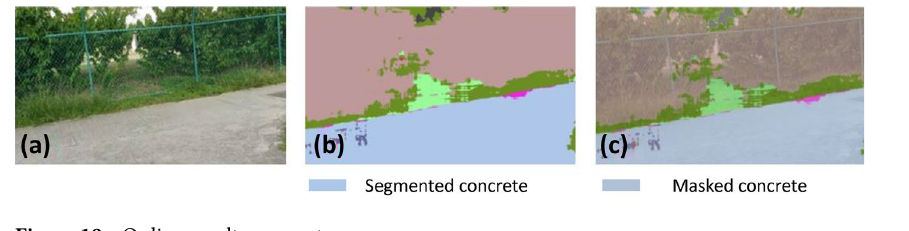
Figure 19. Online results: